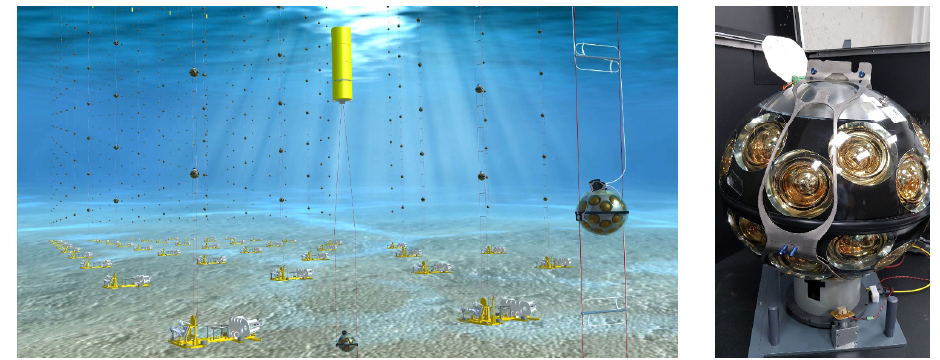
Figure 1. Left: Representation of the KM3NeT experiment. Right: Digital Optical Module.